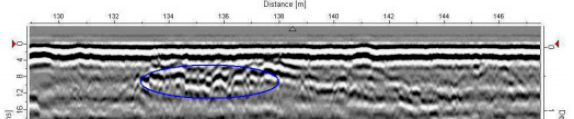
Figure 1. Typical radar map of base void.